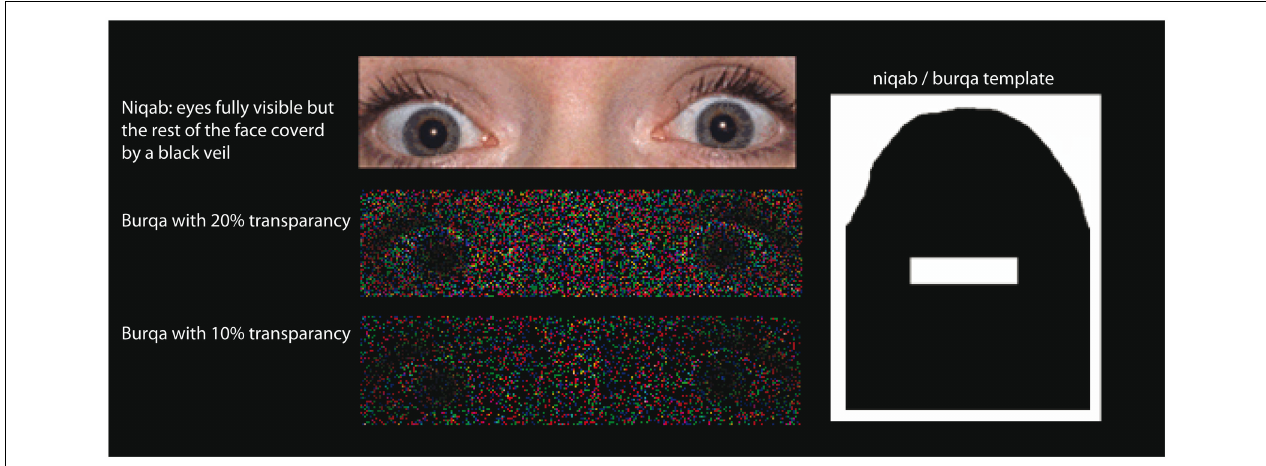
FIGURE 1 | Perception of emotion from the eye region in a cultural context. The eye region was presented in four different contexts: (1) as part of a whole face (which is not shown in this figure but is depicted in Table 1 ),